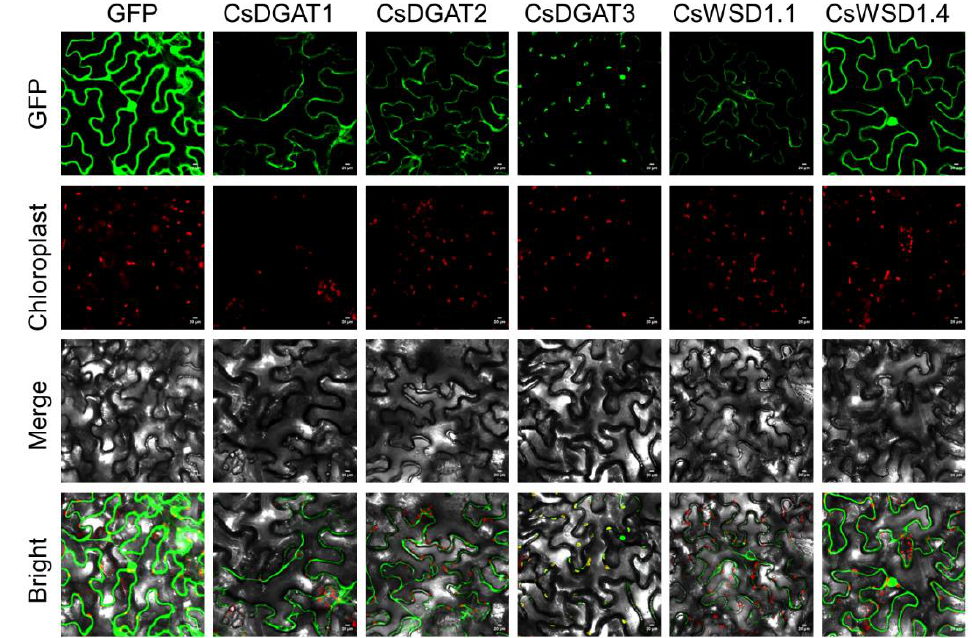
Figure 5. Subcellular localization analysis of CsDGATs proteins. GFP blank vector (control); Tobacco ( Nicotiana benthamiana ) leaves transiently expressed CsDGATs-GFP fusion proteins were observed through the laser scanning confocal microscope. The scale bar label in the lower right corner of each picture represents 20 μ m.